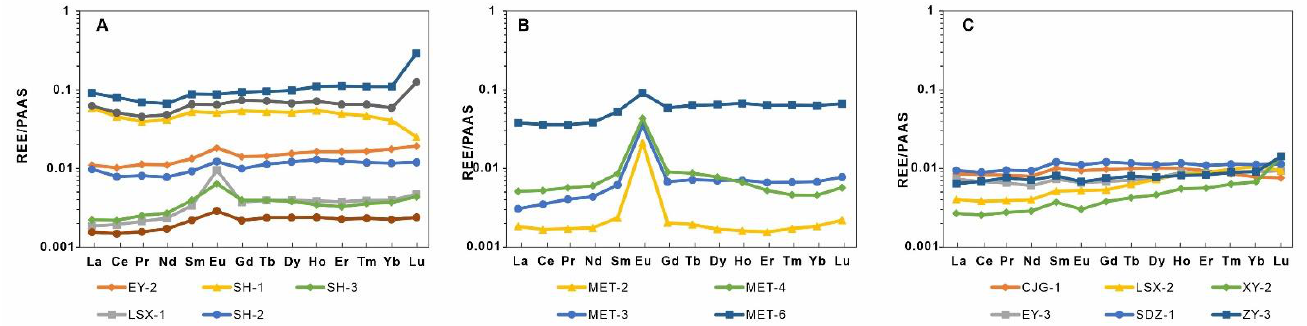
Figure 8. PAAS-normalized REE patterns of cherts and limestones. ( A ) Bedded cherts of Maokou Fm.; ( B ) nodular cherts of Maokou Fm.; ( C ) limestones of Maokou Fm.